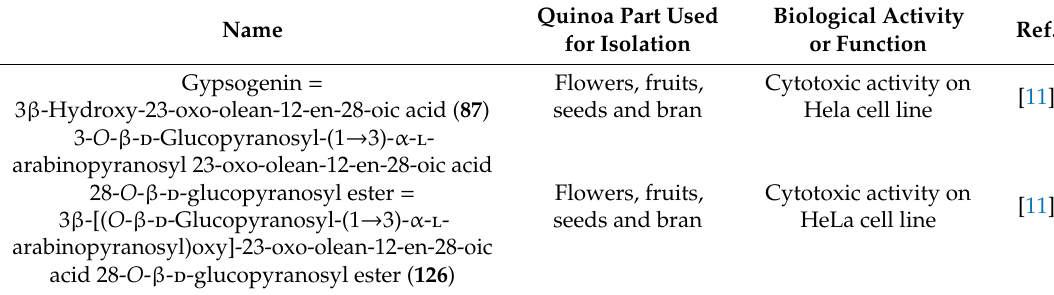
Table 14. Gypsogenin derivatives and their biological activities or